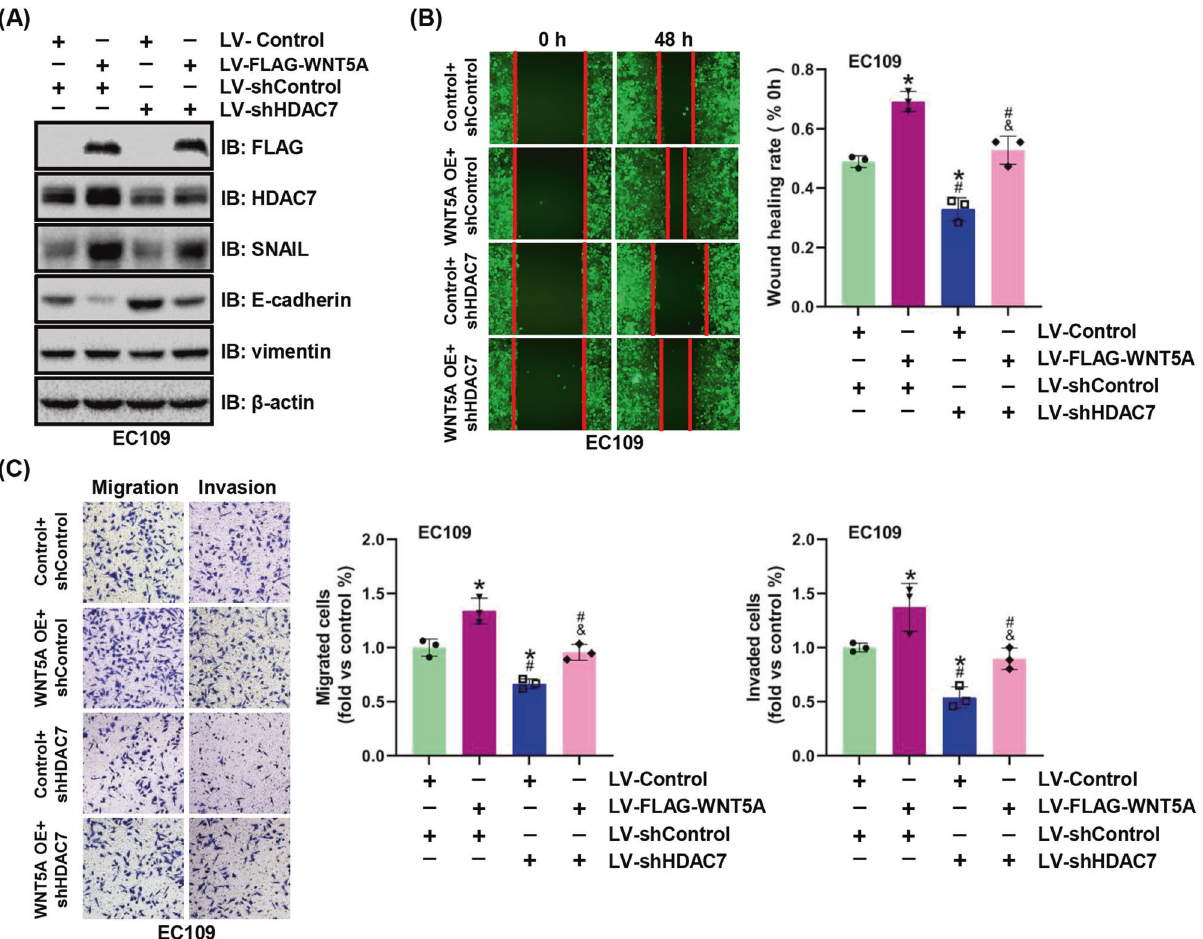
Fig. 5 HDAC7 is essential for WNT5A-mediated ESCC cell migration and invasion. A Representative western blots showing the levels of FLAG-WNT5A, HDAC7, SNAIL, E-cadherin, and vimentin in EC109 cells with WNT5A overexpression and/or HDAC7 knockdown. β -actin was used as an internal control. B , C Representative images and statistical analysis of wound healing assays and Transwell migration/invasion assays in the indicated ESCC cells. The migratory ability in wound healing assays was expressed as the mean scratch area. The initial scratch area (0 h) was set to 100%. * P < 0.05 compared with the LV-Control + shControl group, # P < 0.05 compared with the LV-FLAG-WNT5A + shControl group, and & P < 0.05 compared with the LV-Control + shHDAC7 group. LV HDAC7 is involved in WNT5A-mediated ESCC progression We examined the effect of HDAC7 downregulation by infecting EC109 cells overexpressing WNT5A with the HDAC7-RNAi lenti- virus to con fi rm the involvement of HDAC7 in WNT5A-mediated ESCC progression. Using western blotting, the according changes of HDAC7 and FLAG-WNT5A expressions were veri fi ed, and HDAC7 knockdown reversed WNT5A overexpression induced changes in the levels of EMT biomarkers by decreasing SNAIL and increasing E-cadherin levels (Fig. 5A and Supplementary Fig. S3A). Moreover, the increased migration and invasion induced by WNT5A were partially inhibited by HDAC7 knockdown, as evidenced by the results of the scratch wound assay and